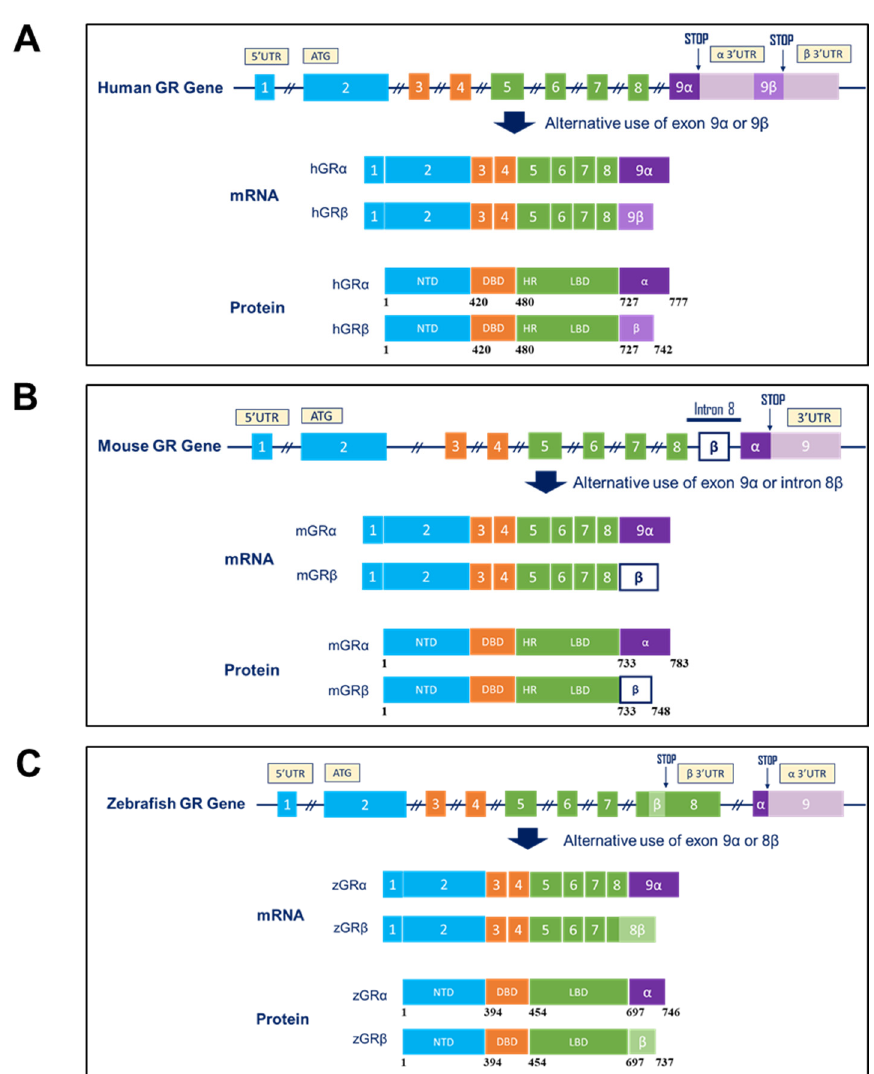
Figure 2. Structure of the GR gene, mRNAs, and proteins in different species. Alternative splicing of the GR β primary transcript differs among species. ( A ) The human GR gene contains the exons 9 α and 9 β , which are alternatively spliced near the end of the primary transcript to generate GR α and GR β mRNAs. GR α originates by joining the end of exon 8 to exon 9 α , whereas GR β is produced by an alternative acceptor site, where exon 8 is joined to the downstream exon 9 β . The originated proteins share identical amino acids up to position 727, and thereafter, the C-terminal of GR α contains 50 additional amino acids (777 aa protein), whereas the C-terminal of GR β contains 15 additional amino acids (742 aa protein). ( B ) The mouse GR β (mGR β ) arises from an alternative donor site located within intron 8, rather than exon 9 as in humans. mGR α and mGR β share identical amino acids up to position 733, and thereafter mGR β possess 15 additional amino acids (748 aa protein). Likewise, rat GR β originates from inclusion of intron 8. ( C ) In zebrafish, GR isoforms originate from intron retention, where zebrafish GR β (zGR β ) arises from alternative use of a splice donor site in exon 8. The zGR β protein contains 737 amino acids and shares the N-terminal 697 amino acids with zGR α . The figure is modified and based on References [14,42,44] and copyright permission was obtained from Oxford University Press and Copyright Clearance Center for reference [42].